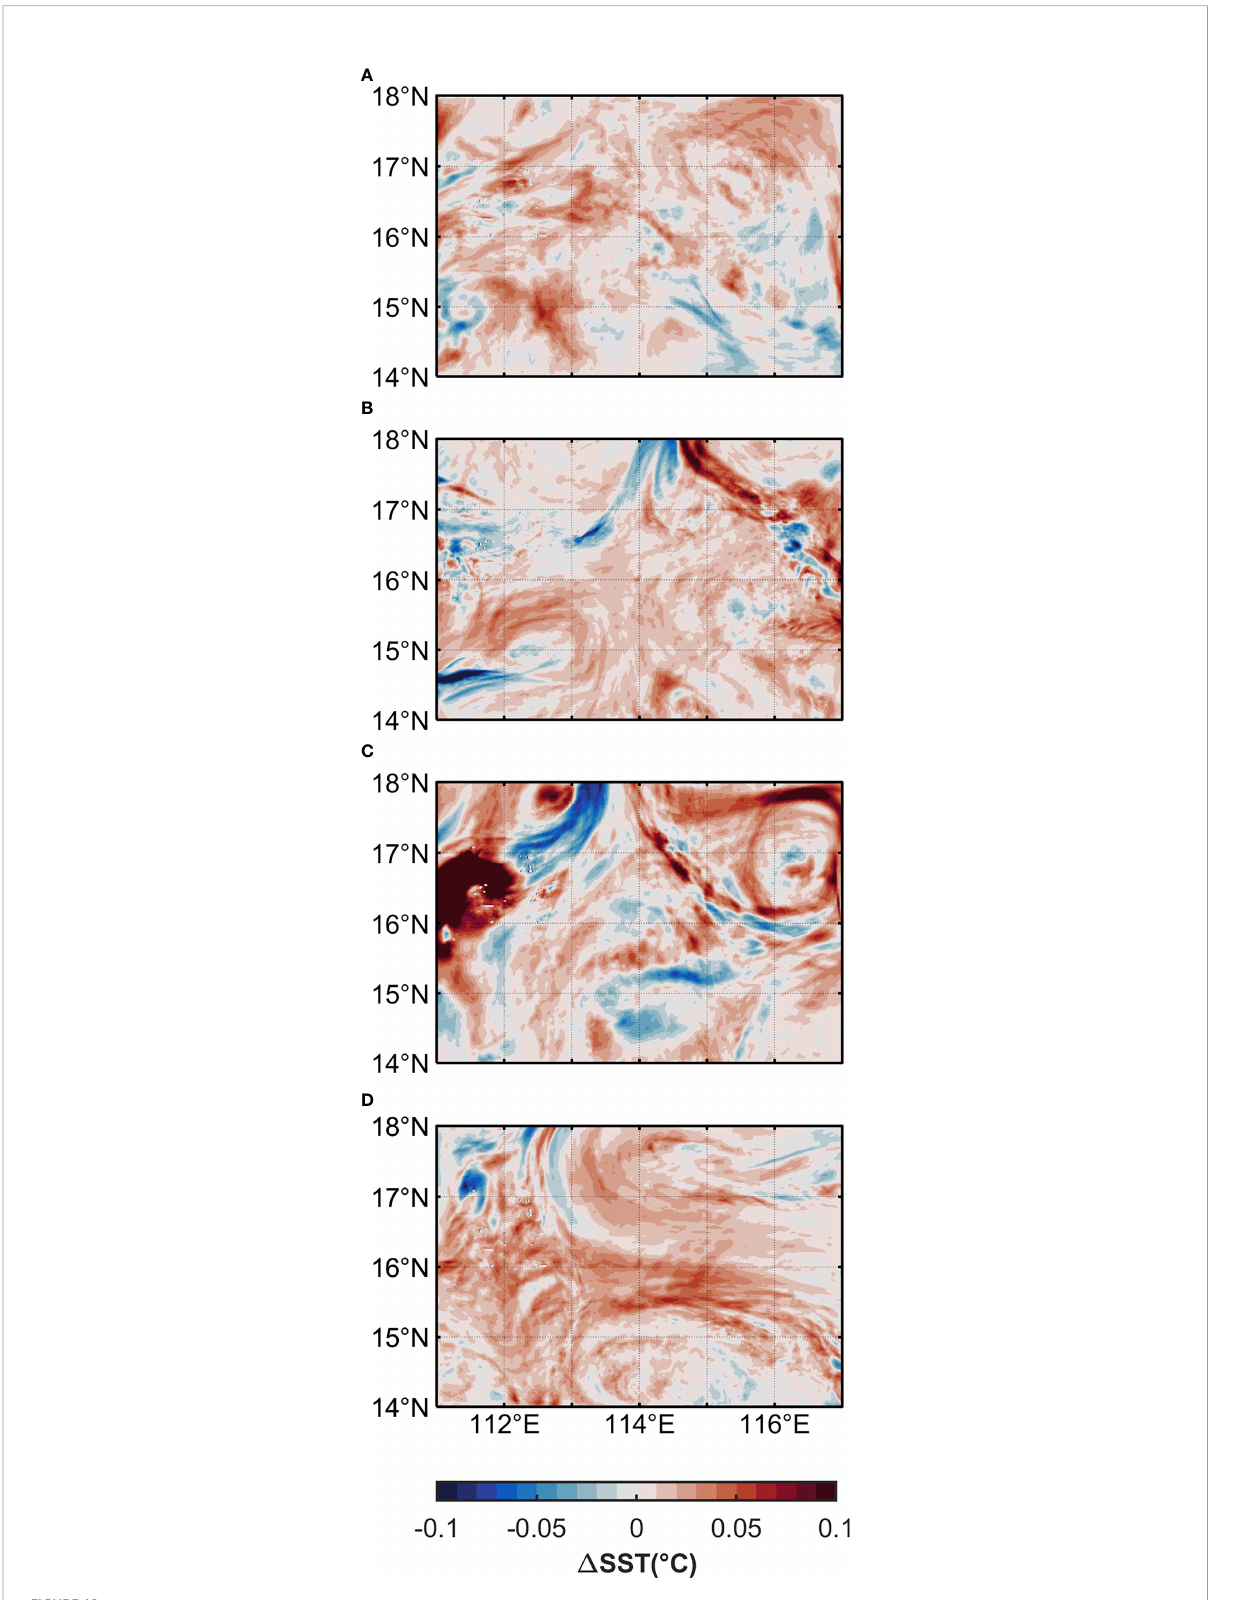
FIGURE 12 SST difference (SI-NOSI) in January (A) 2017, (B) 2018, (C) 2019, (D)